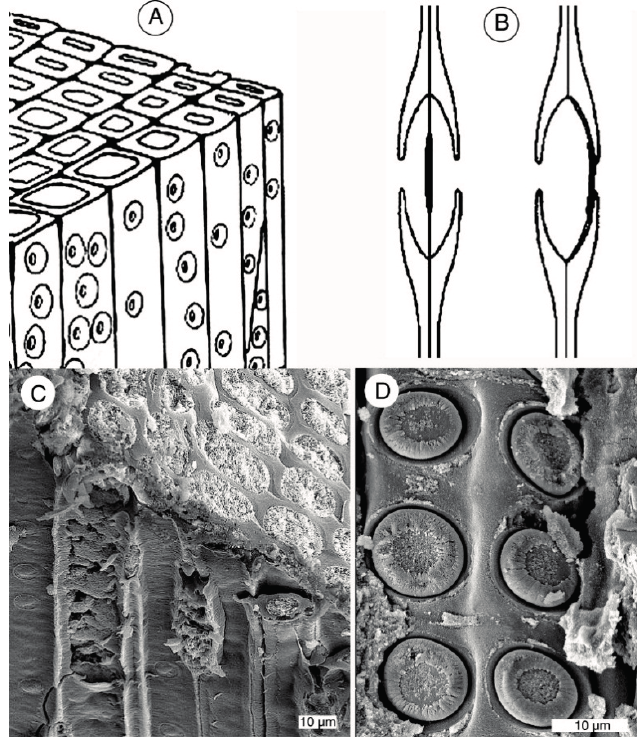
Figure 9. Wood anatomy. ( A ) Tracheids are parallel cells that provide fluid conduction, being laterally connected by circular pits; ( B ) Each pit contains a circular plate (torus) supported by a thin membrane. The torus allows the pit to open or close depending on the fluid pressure or vapor pressure of adjacent cells; ( C ) Oblique radial view of wood silicified with opal-CT, locality 2 (Royal Peacock opal mine); ( D ) High magnification radial view of opal-CT wood showing details pf pit anatomy, locality 2 (Norita opal